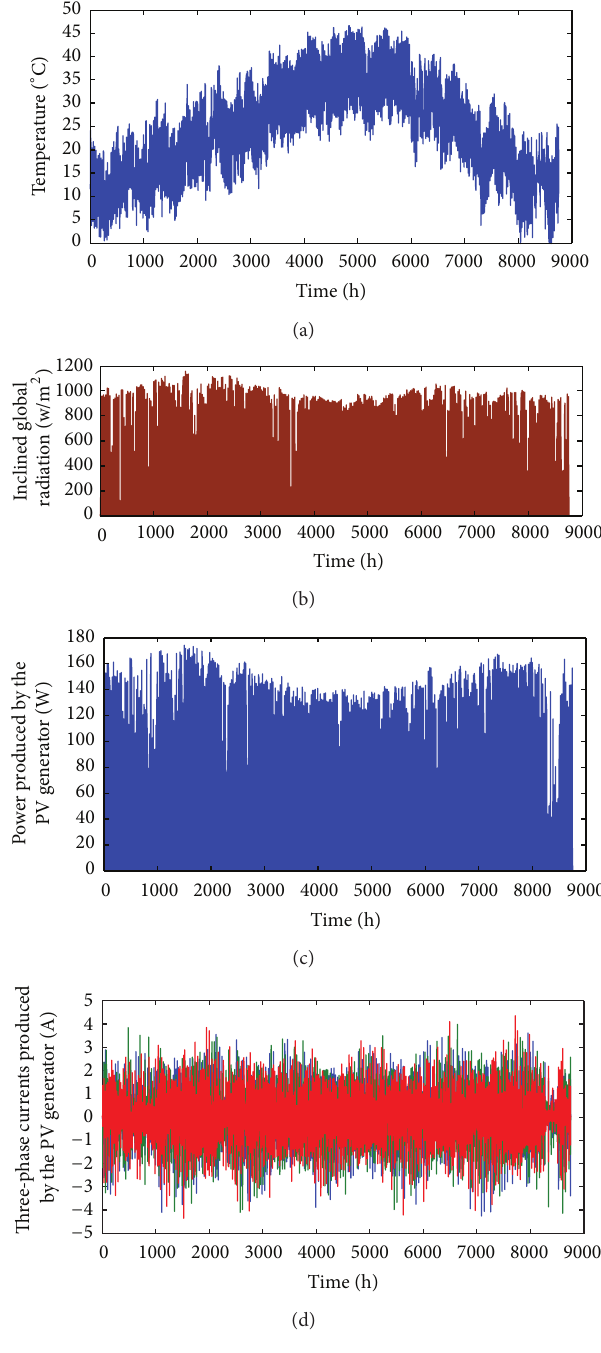
Figure 6: Representation of climatic characteristics, power, and current produced by the photovoltaic module BP SX 150S installed on the Adrar